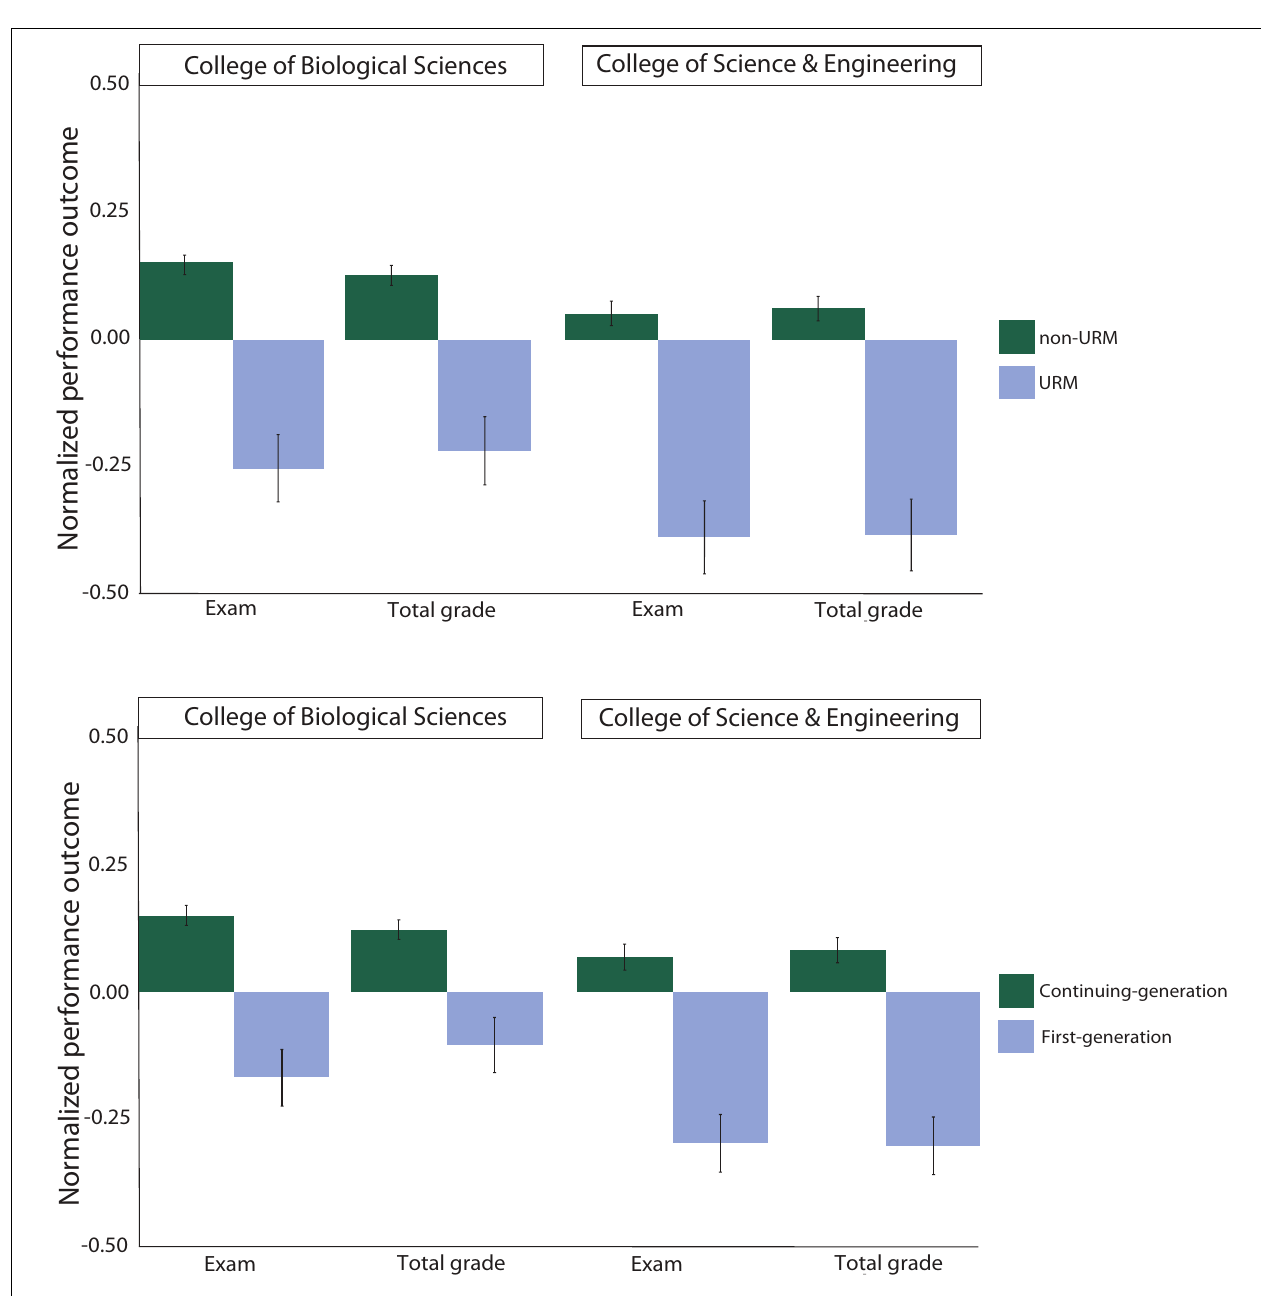
FIGURE 4 | Average normalized exam scores and total grades. Students across the College of Biological Sciences and the College of Science & Engineering include majority (non-URM; green), underrepresented minority students (URM; light blue) (top panel) ; and continuing generation (green) versus first-generation (light blue) college attendees (bottom panel)